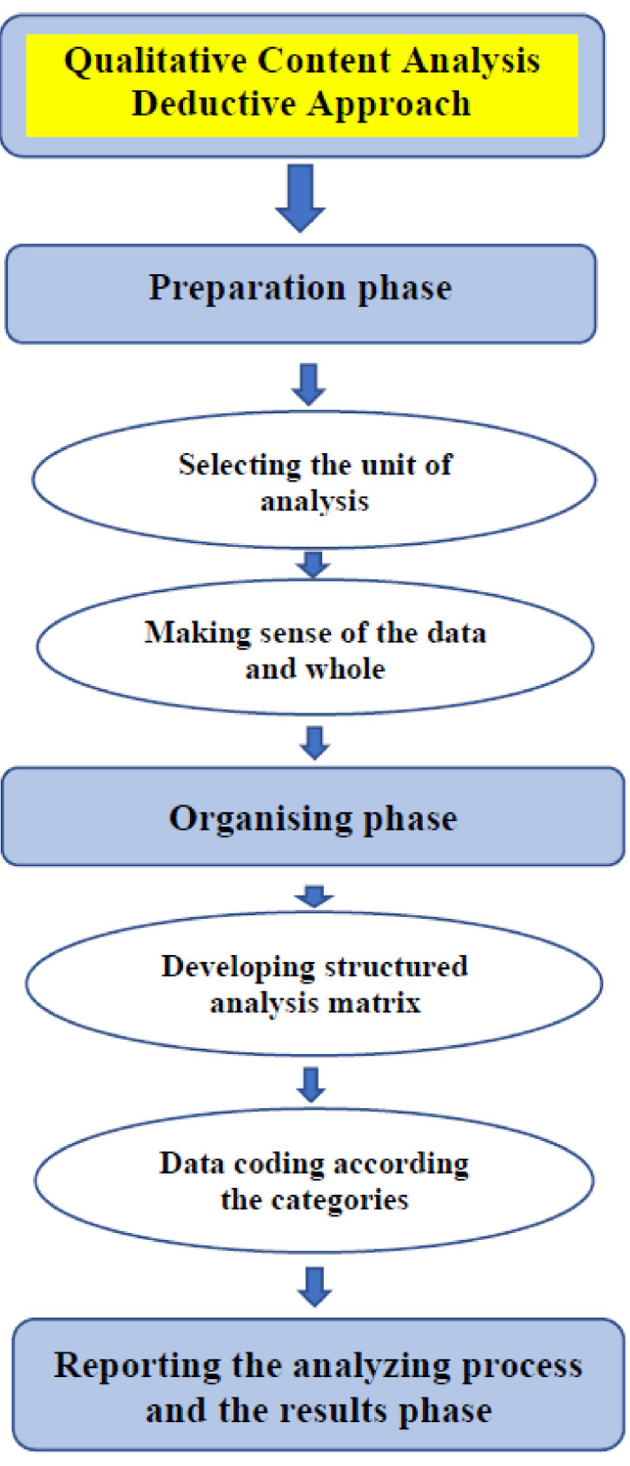
Fig 2. Phases of preparation, organizing, and reporting in the deductive content analysis process [31].